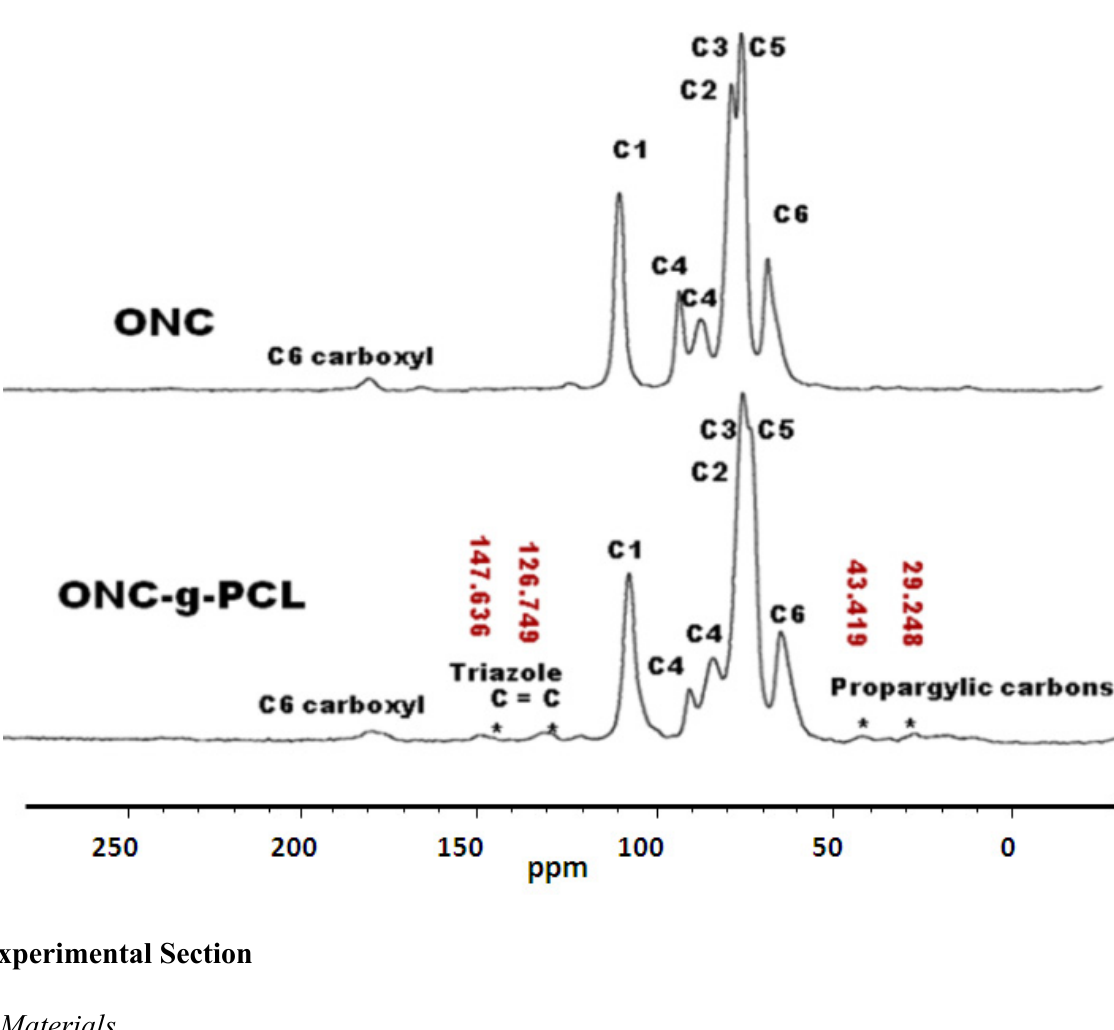
Figure 7. 13 C-NMR spectra of ONC and